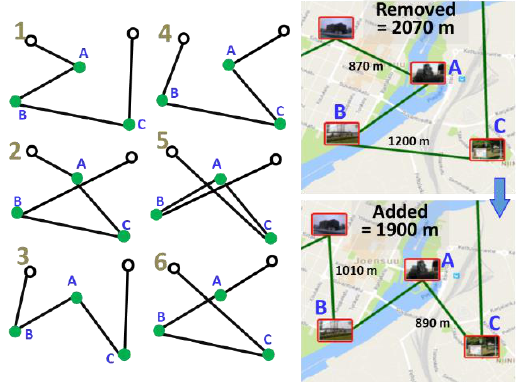
Figure 6. All six combinations of 3 – permute and an O – Mopsi game example that is improved by 170